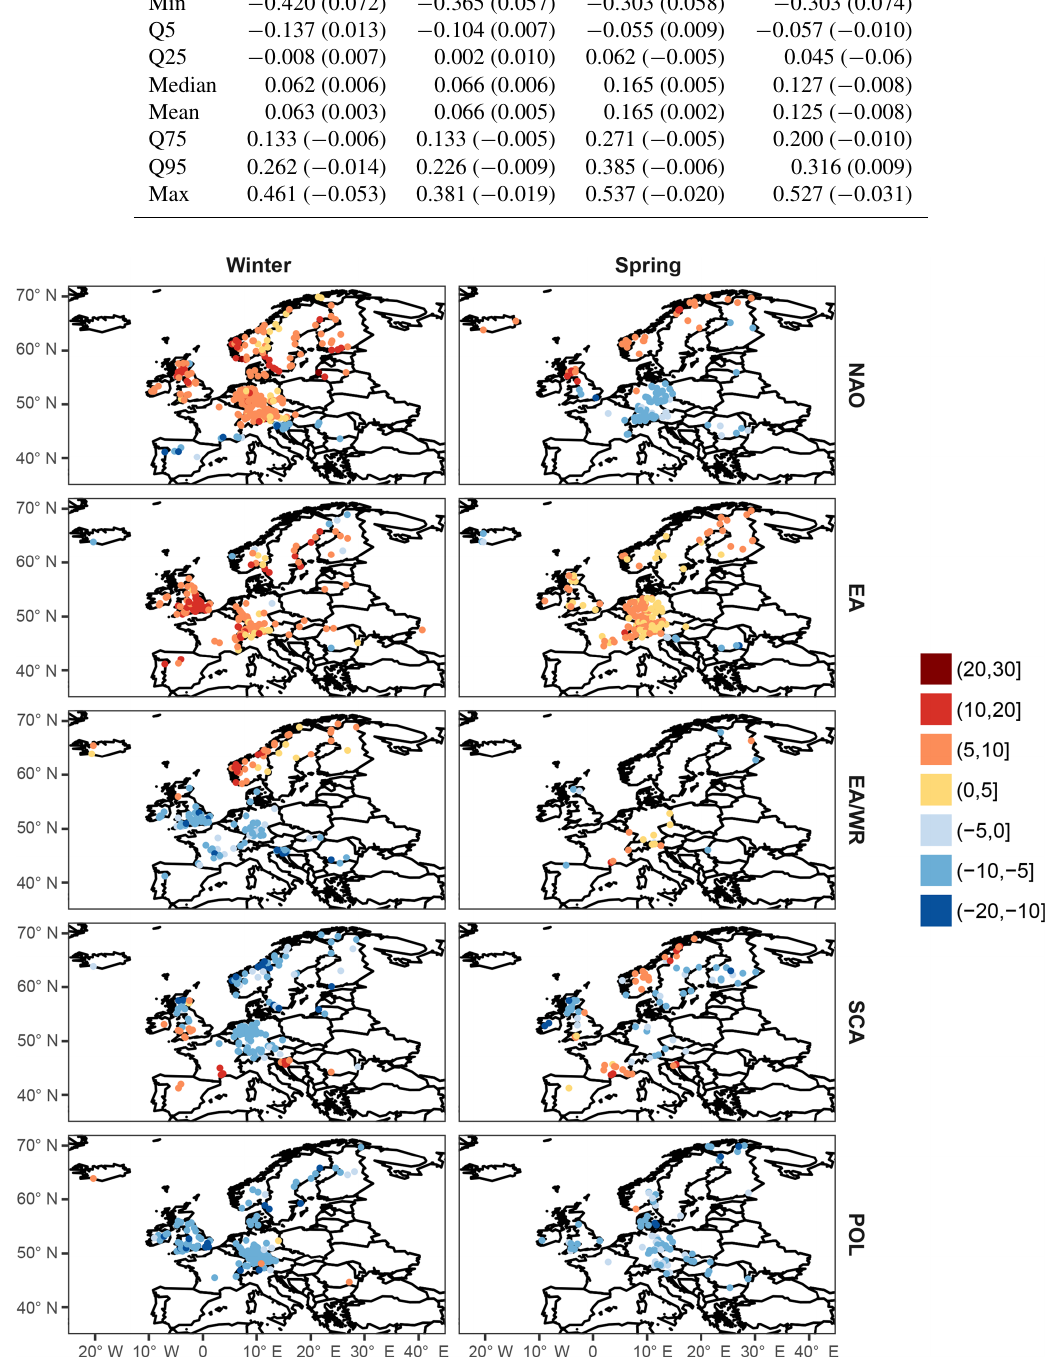
Figure 5. Percentage of the relative difference of the streamflow for an exceedance probability of 0.02 between a (hypothetical) year with a climate index value equal to the 95th quantile and a year with an index value equal to the median index. Results are shown for winter and spring and seasonal mean